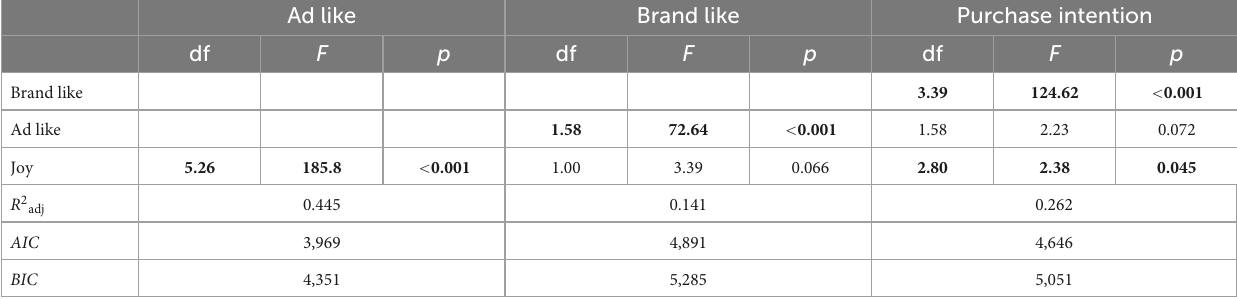
TABLE 2 Prediction of ad likeability, brand likeability change, and brand purchase intention change based on relevant self-report ratings. Ad like Brand like Purchase intention